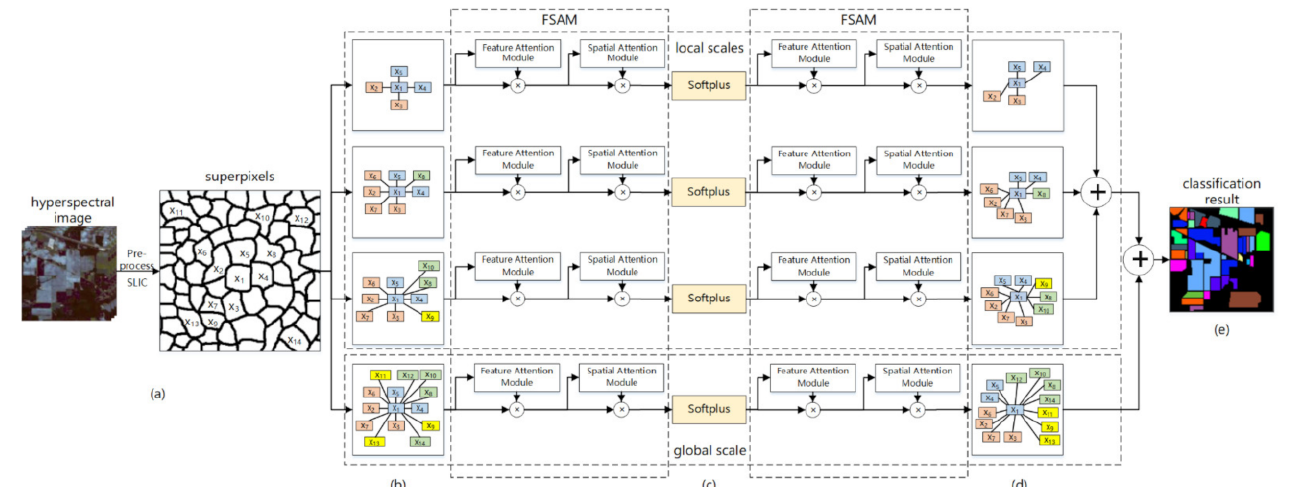
Figure 1. The framework of MFEGCN-FSAM. In process ( a ), the initially input HSI is divided into superpixels by the SLIC method after a series of preprocessing. For a demonstration, suppose there are 14 superpixels x1, x2, . . . , x14 now. In ( b ), these superpixels construct the graphs on different scales, respectively. The rectangles and lines represent nodes and edges, different colors represent different land-cover types. ( c ) Represents the graph convolution part of the model. Each scale has two graph convolution layers, and each graph convolution layer contains an FSAM. The graph was automatically updated after being processed by FSAM, and softplus [52] was used as the activation function. ( d ) Represents the output results of the convolutional layers at different scales. The final classification result ( e ) was obtained by weighted summation of the output of the multiscale